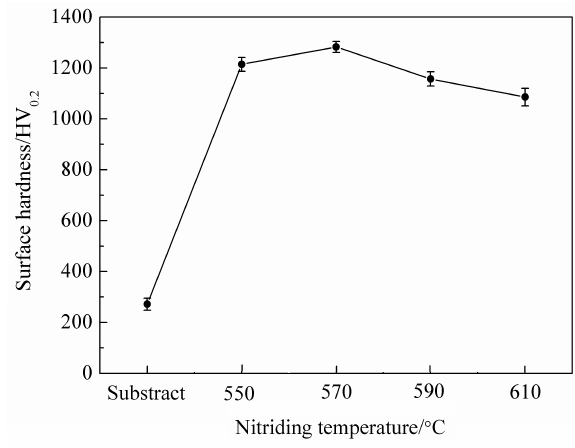
Figure 5. Surface hardness of the substrate and two samples.